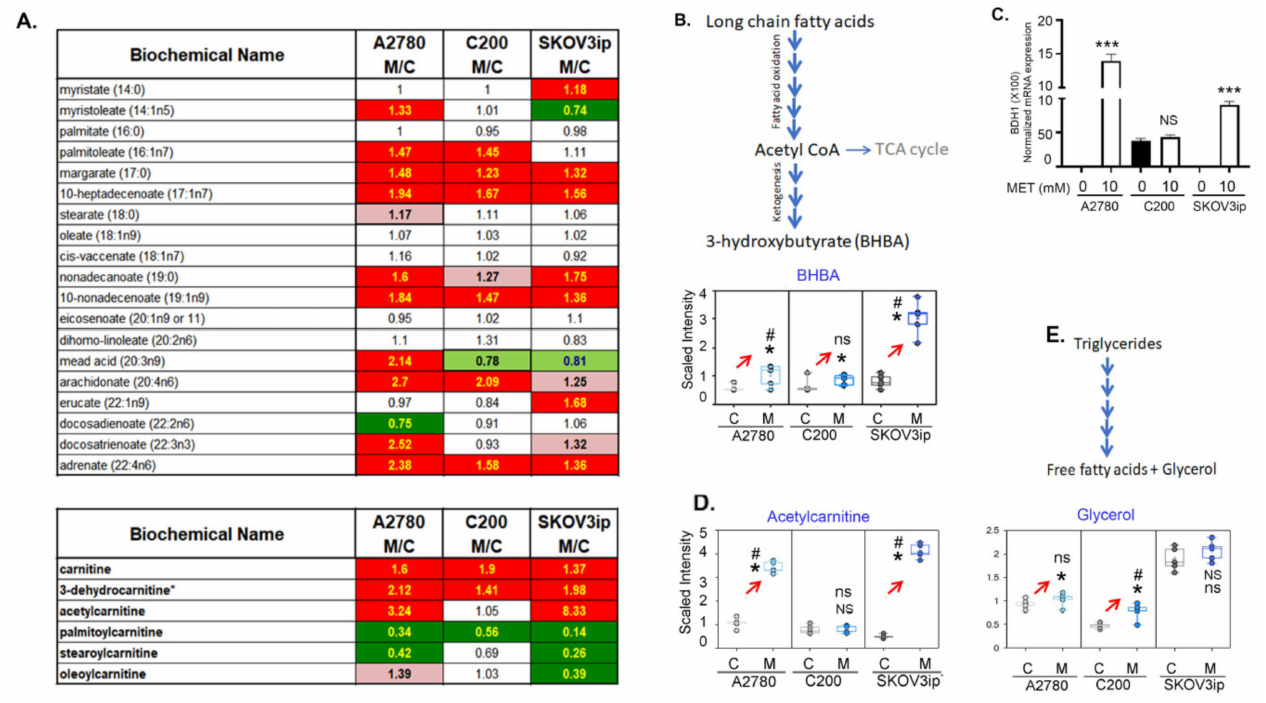
Figure 4. Increase in fatty acid metabolism by metformin. Selective analysis of lipid metabolism from the untargeted metabolomics was performed in untreated control ( C ) and 10 mM metformin (M)- treated cells. ( A ) Fold-change in mean metabolite intensity in fatty acids and carnitines in response to 10 mM of metformin treatment in A2780, C200, and SKOV3ip cells, relative to untreated cells. Dark green indicates a significant difference (FDR ≤ 0.05) between the groups; light green indicates differences approaching significance (0.05 ≤ FDR ≤ 0.10) between the groups shown; red indicates a significant difference (FDR ≤ 0.05) between the groups; and pink indicates differences approaching significance (0.05 ≤ FDR ≤ 0.1) between the groups. ( B ) Pathway depicting metabolism of ketone body BHBA (beta-hydroxybutyrate) and its log-transformed scaled intensity boxplot. ( C ) mRNA expression of BDH1 (beta-hydroxybutyrate dehydrogenase) transportation of long-chain fatty acids, scaled intensity showing levels (BHBA) in A2780, C200, and SKOV3ip after metformin treatment. *** p ≤ 0.001, NS = non-significant when metformin treated compared to untreated. ( D ) Scaled intensity levels of acetyl carnitine in A2780, C200, and SKOV3ip after metformin treatment. ( E ) Scaled intensity levels of glycerol in A2780, C200, and SKOV3ip after metformin treatment. For all box-plot graphs, * p ≤ 0.05, NS = p non-significant, # q ≤ 0.05, ns = q non-significant when metformin treated compared to